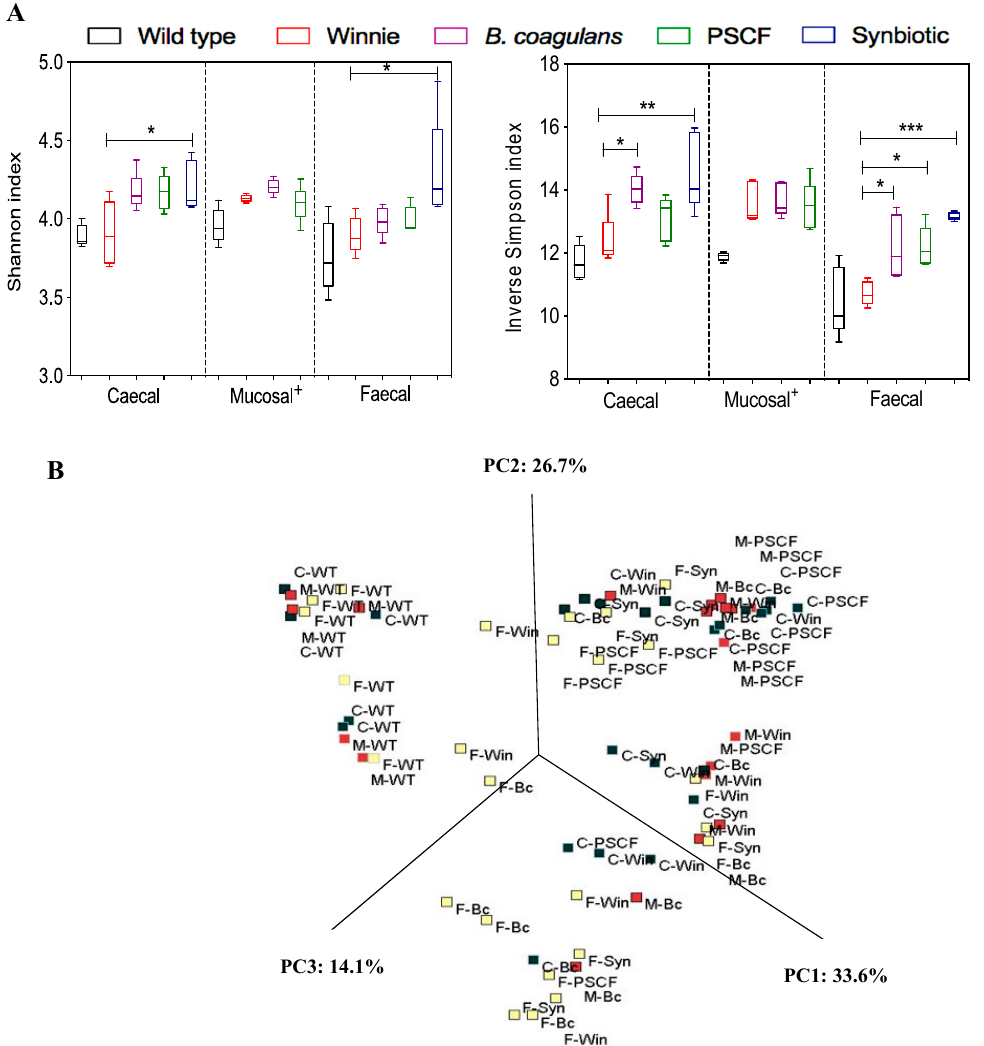
Figure 6. Effect of supplementations on microbial diversity amongst caecal (C-), mucosal-associated (M-) and Faecal (F-) contents of wild-type (WT), Winnie-control (Win), B. coagulans (Bc) spores, PSCF and Synbiotic (Syn) groups. ( A ) Comparison of Alpha ( α ) diversity indices. Statistical significance among groups evaluated by one-way ANOVA. * p < 0.05, ** p < 0.01, *** p < 0.001 Versus Winnie-control group (+ = mucosal Synbiotic sample data could not be determined). Data expressed as mean ± SEM ( n = 5 per group). ( B ) Principal component analysis (PCoA) plot based on Bray-Curtis distances.